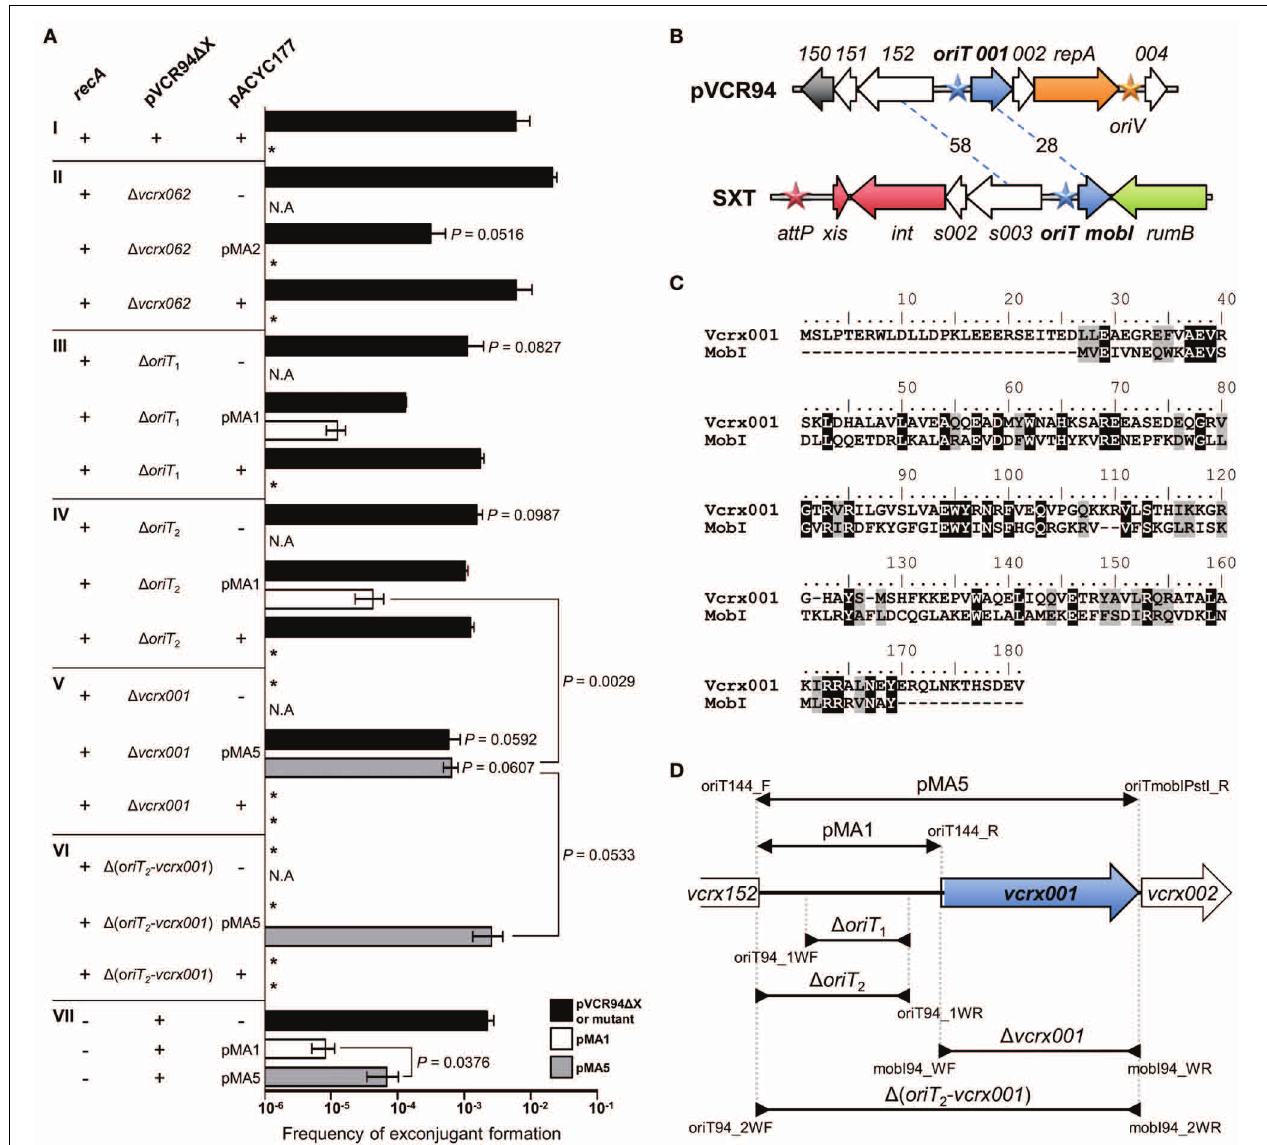
FIGURE 4 | Identification of the oriT locus of pVCR94. (A) Conjugation and mobilization assays were carried out to assess the impact of deletion, and the ability to trans -initiate transfer of the indicated regions cloned into pACYC177 (see panel D ). In every experiment, pVCR94 (cid:2) X was used as a positive control for efficiency of transfer, and pACYC177 was used as a negative control for mobilization assays. Frequency of transfer of each deleted region was compared to the mobilization frequency of its cognate cloned sequence. Within each mating experiment, exconjugants were selected for their acquisition of either the pACYC177 derivatives, pVCR94 (cid:2) X derivatives, or for cotransfer of both, when applicable. All mating experiments that involved recA + strains were made from BW25113 Nx R as donor toward the Tc R strain CAG18439 as recipient. Transfers done in a recA − background involved BW25113 (cid:2) recA :: aad7 (VB45) and KB1 as donor and recipient strains, respectively. The bars represent the mean and standard deviation values obtained from three independent experiments. Asterisk indicates that frequency of exconjugant formation was below the limit of detection ( < 10 − 8 ). N.A. indicates that the selection was not applicable in the mating experiment. Statistical analyses were performed using the two-tailed Student’s t -test. P -values are indicated above the bars when comparison referred to pVCR94 (cid:2) X (panel AI ) or above the brackets comparing two bars. (B)